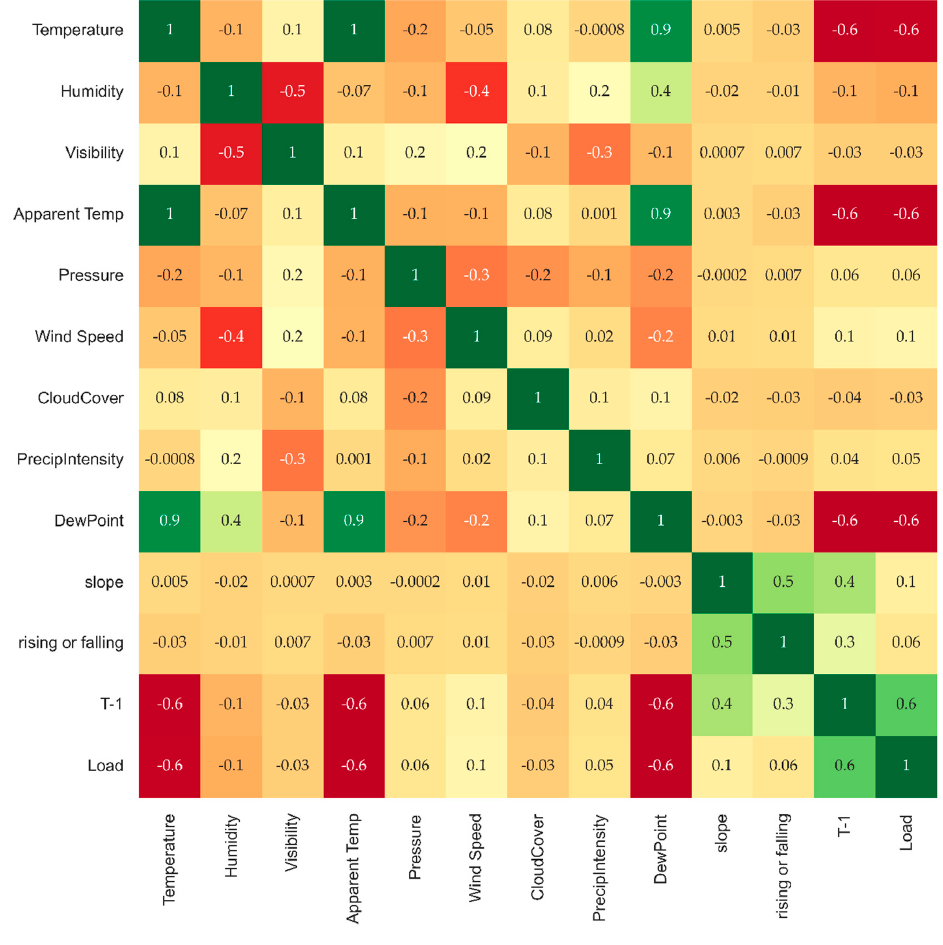
Figure 7. Correlation map of input features and electric load. Each model, i.e., LSTM, GRU, and Bi-LSTM, has one hidden layer with 200 internal units, a learning rate of 0.001, and Adam as an optimizer. These three models were